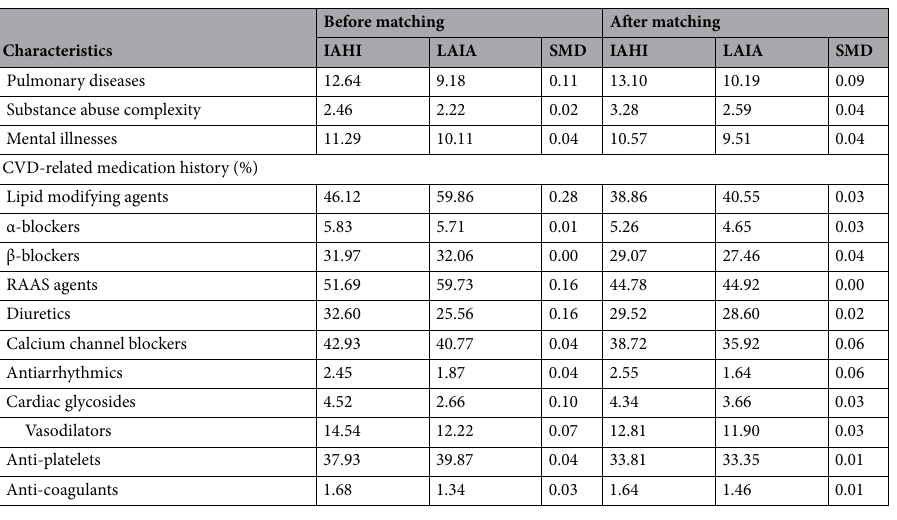
Table 1. Baseline patient characteristics before and after application of the matching algorithm. IAHA, intermediate-acting human insulin; LAIA, long-acting insulin analogue; SMD, standardized mean difference; GLA, glucose-lowering agent; SD, standard deviation; MPR, medication possession ratio; CIC, Chronic Illness with Complexity; CVD, cardiovascular disease; RAAS, renin–angiotensin–aldosterone